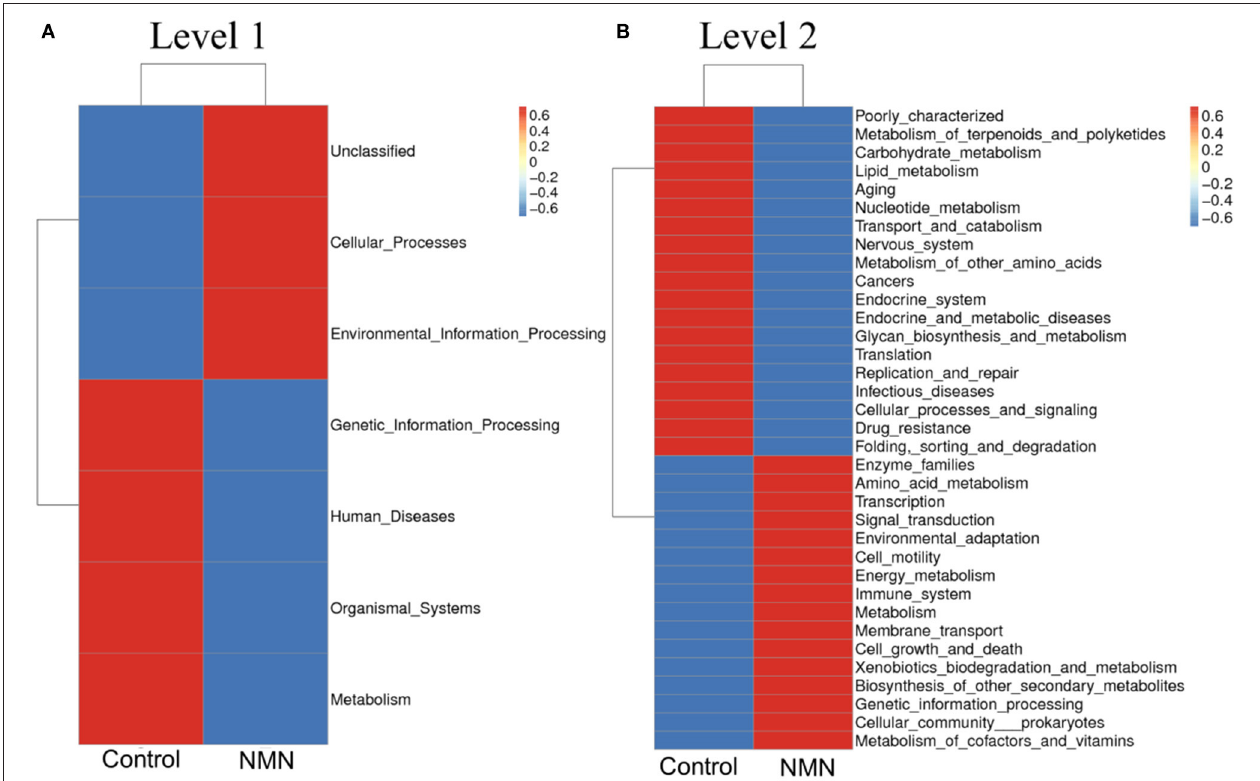
FIGURE 6 | Supplementary effect of NMN on predicted functions of fecal bacteria in pre-aging mice. (A) level 1, (B) level 2.